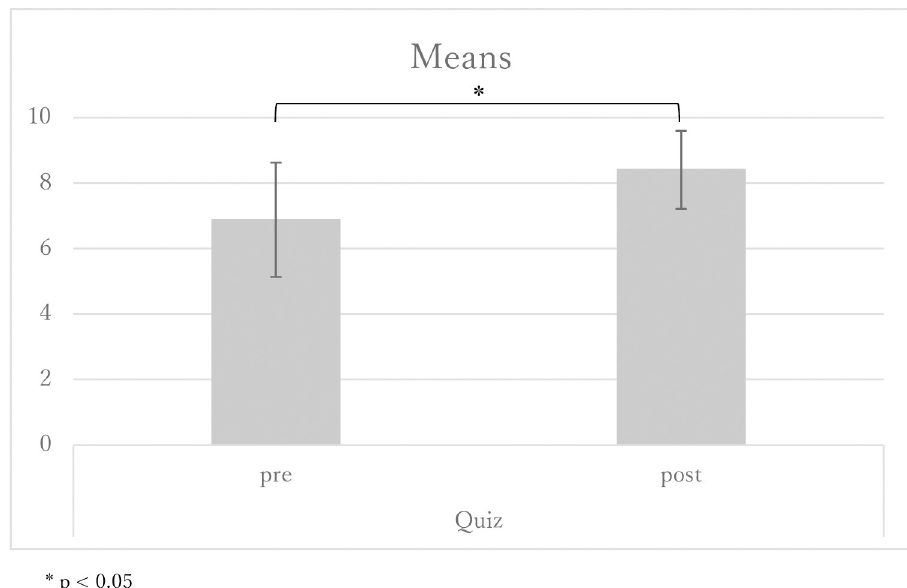
Fig 3. Means of the mini-quiz, pre- and